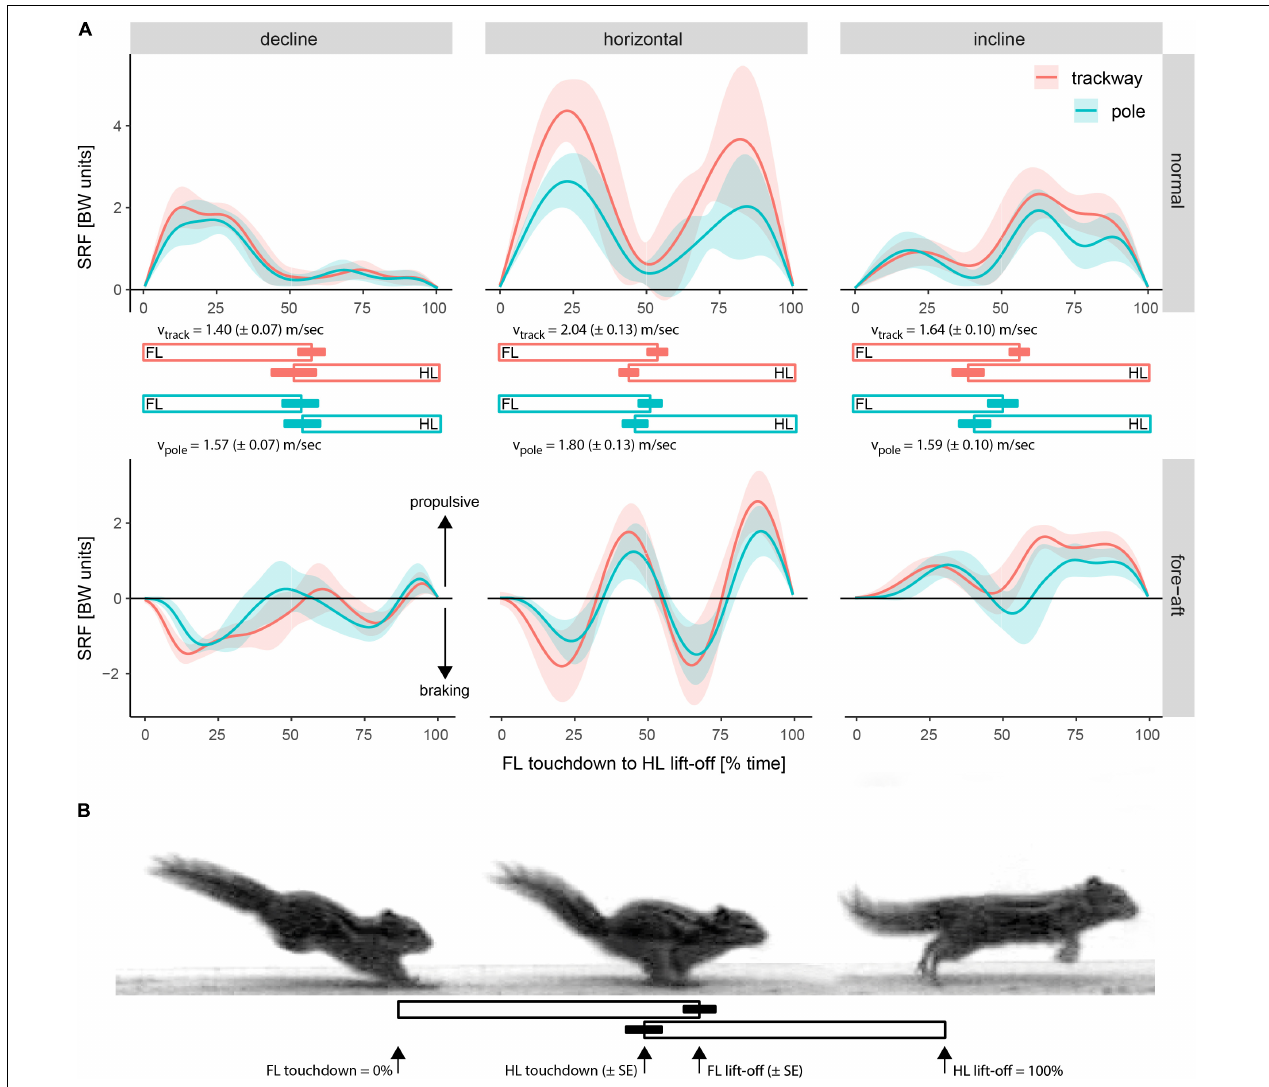
FIGURE 6 | Differences in the average support reaction force trajectories over time among setups. (A) Support reaction force (SRF) of all limbs combined in percentage of body weight (BW units) depending on time from forelimb (FL) touchdown to hind limb (HL) lift-off [%]. Shaded areas represent values within a range of ± one standard deviation from the mean SRF. Bars indicate the average support duration [%] ± one standard deviation from the mean for the forelimbs and hind limbs on each setup. The average running speed (v) ± one standard error is reported for each setup to facilitate the comparison of SRFs (see Results). (B) Illustration of typical touchdown and lift-off